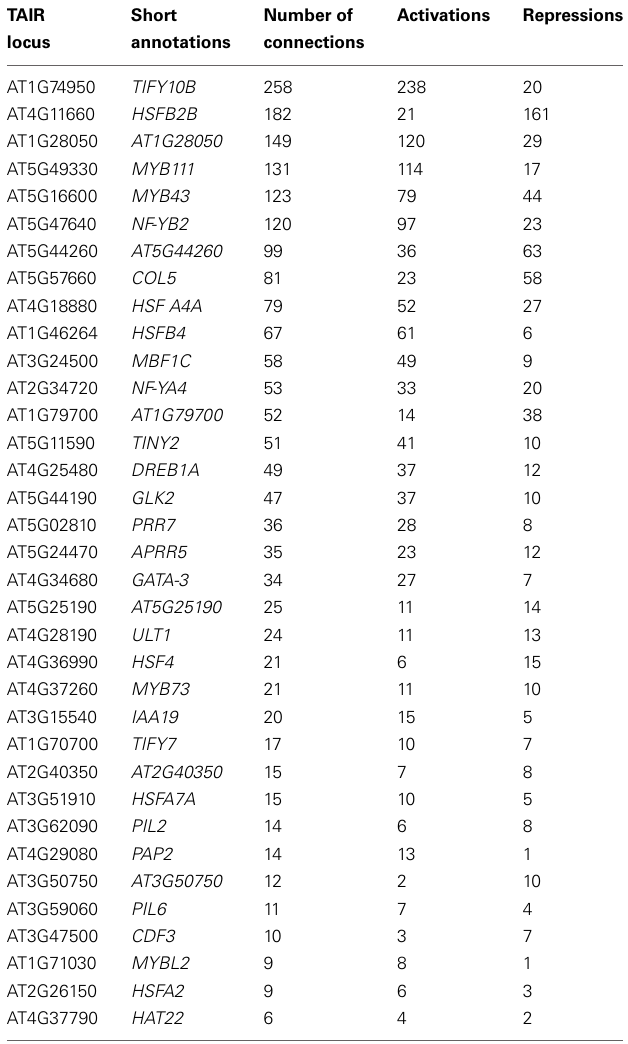
Table 2 | Number of predicted regulatory connections for each of the TFs. TAIR